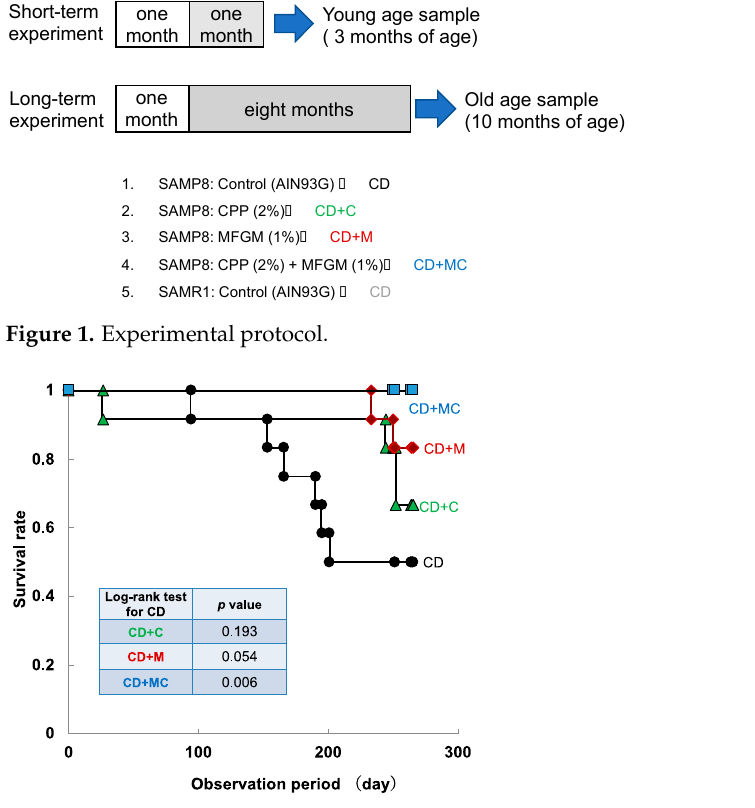
Figure 2. Reduction in mortality of SAMP8 due to CCP and MFGM intake. In the long-term experiments, SAMP8 mice ( n = 12/group) were fed diets containing CPP and/or MFGM ad libitum.